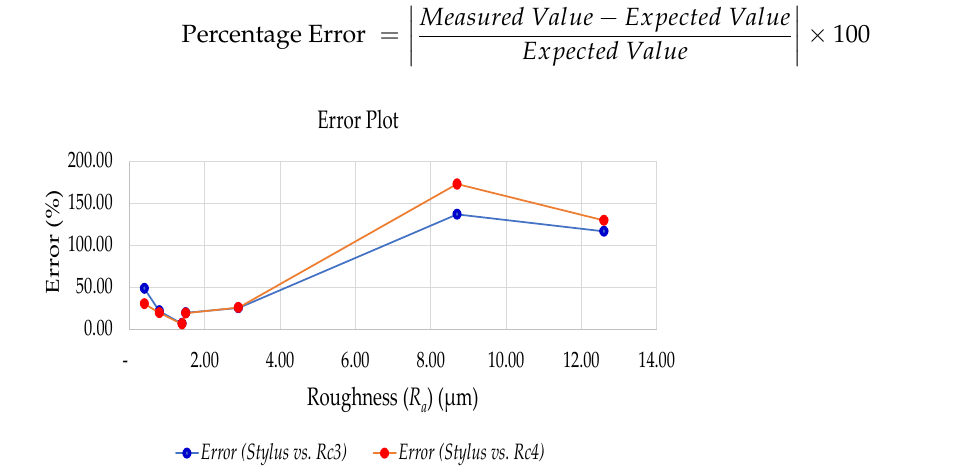
Figure 10. Error plot for the estimated R c3 and R c4 against measured R a.